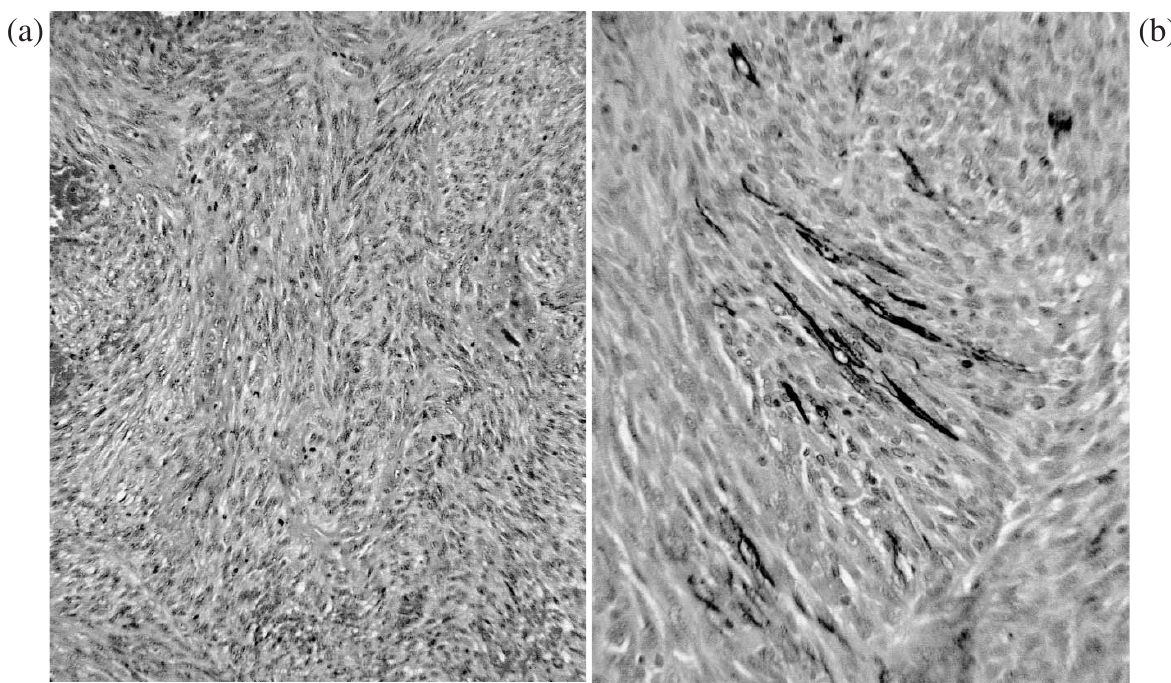
Fig. 1. (a) Low power H&E stain reveals a diffusely elongated spindle cell neoplasm from a 1.5-cm tumor. (b) Representative high power view of immunostain for smooth muscle antigen (SMA). Additional stains for desmin, muscle specific antigen, keratin, HMB45, and S100 were negative.